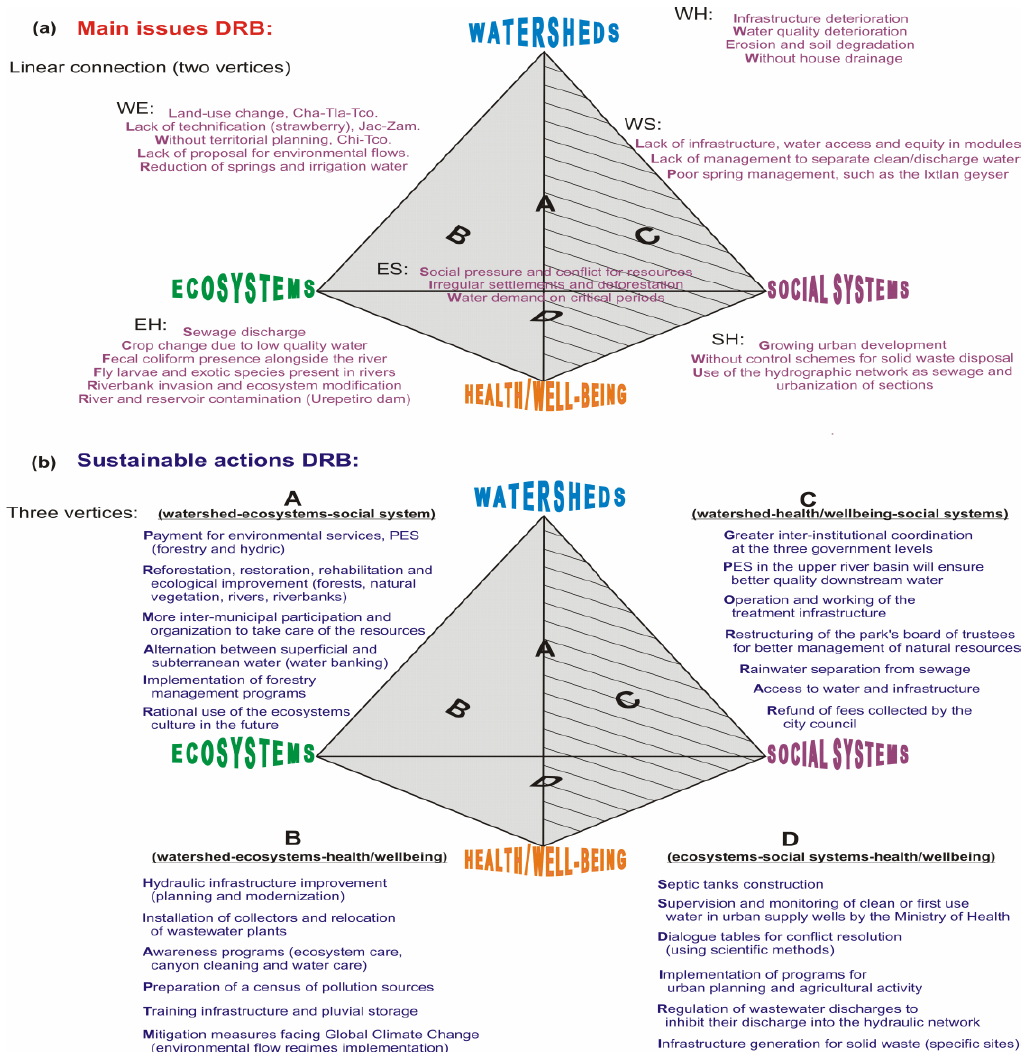
Figure 12. Shows the theoretical framework of the WGP [11]: ( a ) the main problems presented in the DRB, linked in each axis of the prism, thus identifying the type of problem (EH: ecosystems‒health/well- being, WE: watersheds‒ecosystems, WH: watersheds‒health/well -being, WS: watersheds‒social systems, SH: social systems‒health/well - being, and ES: ecosystems‒social systems). Likewise, ( b ) shows the main proposals aimed at improving the sustainability and resilience of resources in the DRB. Municipalities: Jacona (Jac), Zamora (Zam), Chilchota (Chi), Tangancicuaro (Tco), Tlazazalca (Tla), Tangamandapio (Tmp), Chavinda (Cha), and Ixtlan (Ixt). Source: own elaboration based on Parkes et al. [11], Velázquez [24], and CONAGUA-IPN [25].